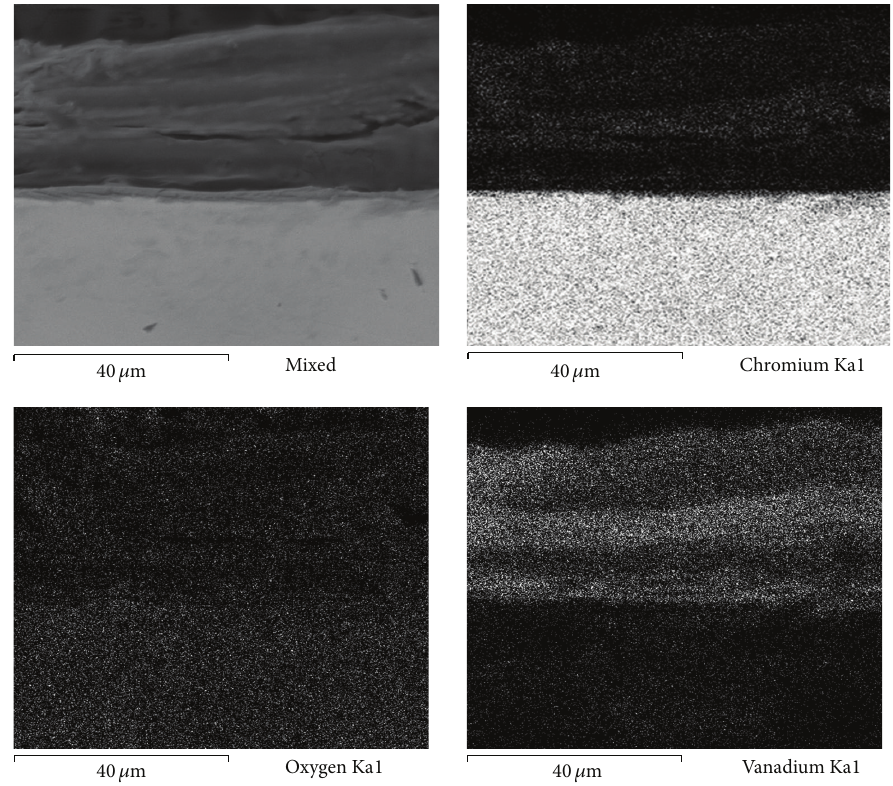
Figure 2: Electron image of the metal-scale interface and X-ray mappings of Cr, O, and V when pure metal chromium was exposed to NaVO 3 at 700 ∘ C during 100 hours.